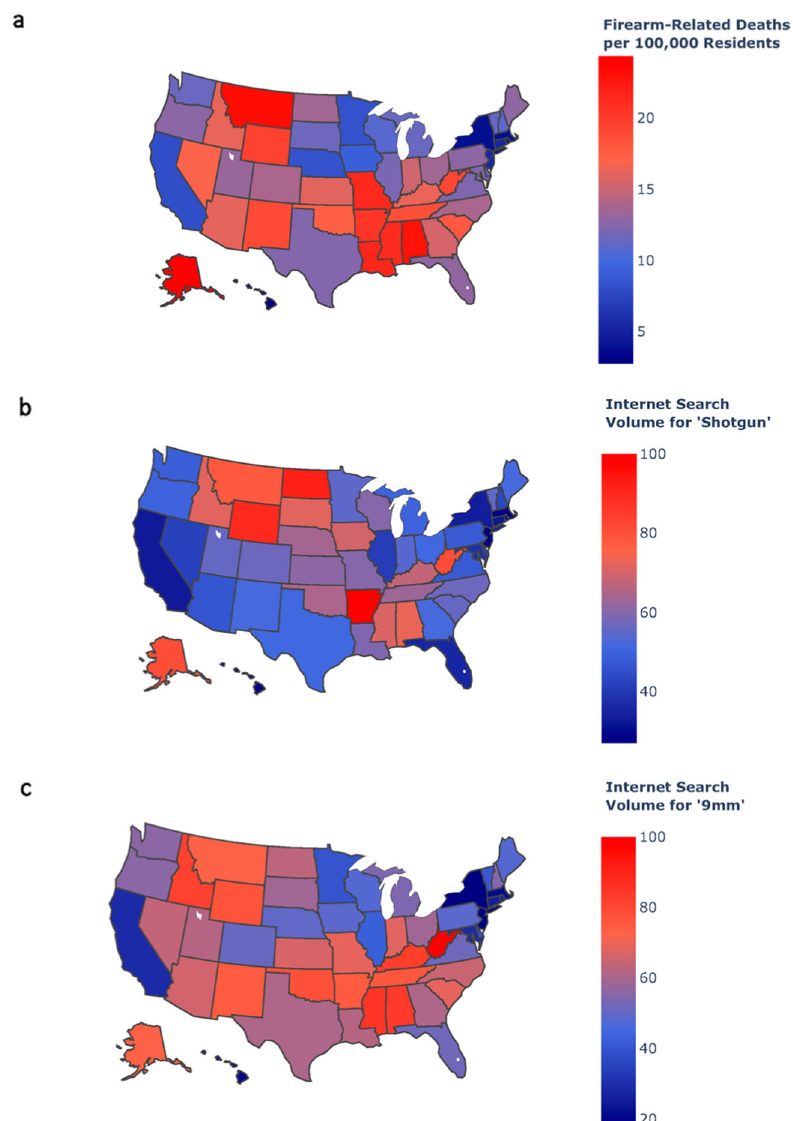
Fig. 5 Geographic view of fi rearm deaths and search volumes. a Firearm-related deaths per 100,000 residents b Relative search volume for the term shotgun . c Relative search volume for the term 9mm across all 50 US states in 2017. All maps produced with Plotly version 4.11, available through an MIT License